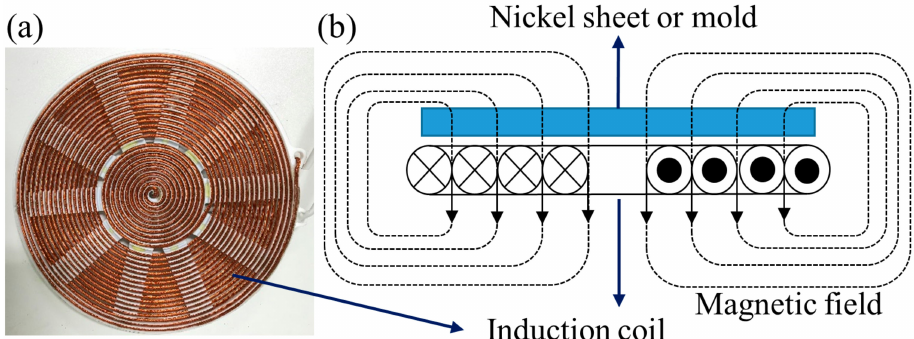
Figure 2. ( a ) Photograph of the customer-made induction coil panel; and ( b ) schematic illustration of induction heating for nickel